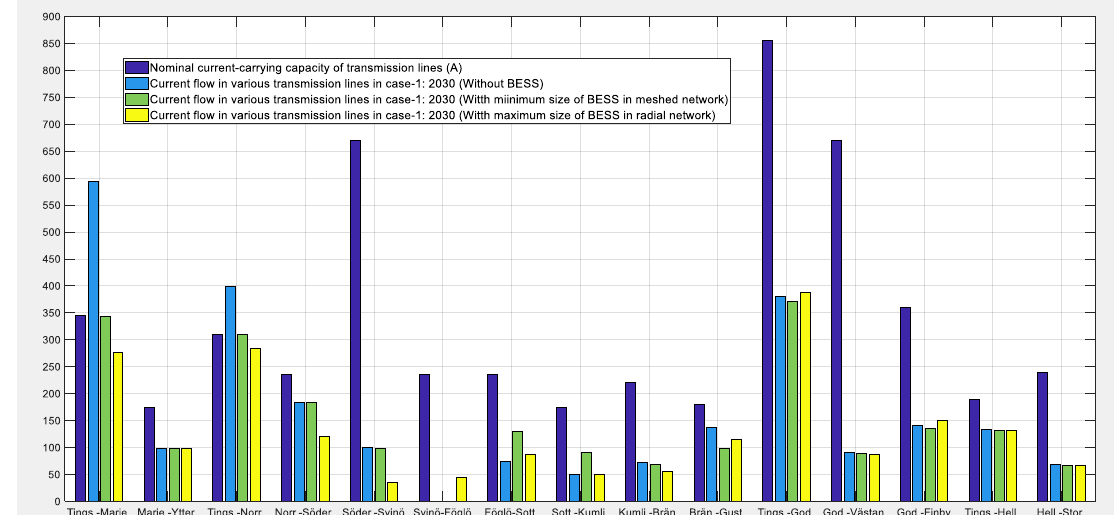
Figure 18. Nominal and actual current flows in transmission lines for the year 2030 with BESSs.